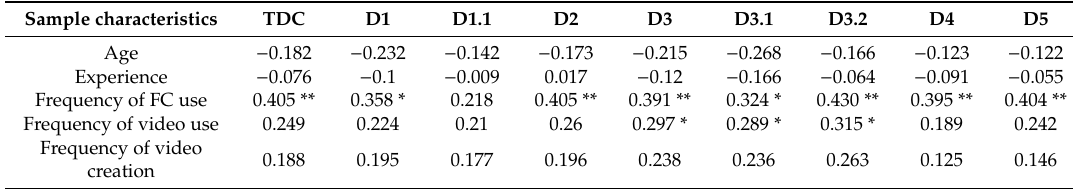
Table 4. Rho Spearman coe ffi cients were calculated for correlations between the sample characteristics and TDC as well as between the sample characteristics and dimensions D1, D2, D3, D4, and D5 and sub-dimensions D1.1, D3.1, and